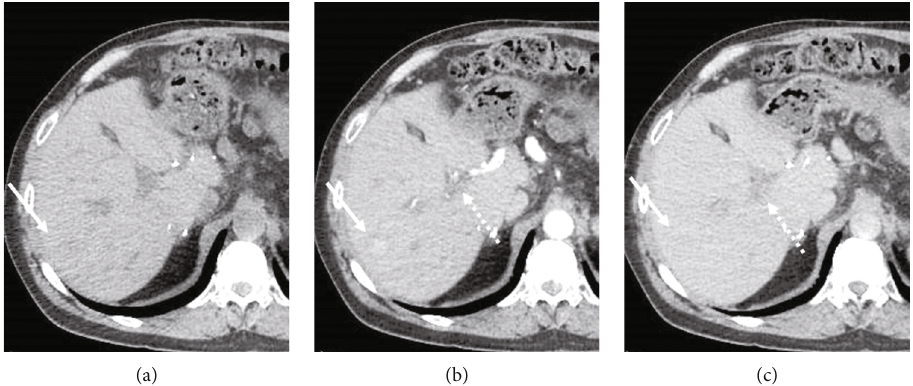
Figure 3: Retrospective review of a contrast-enhanced CT of the liver performed 8 months prior to contrast-enhanced MRI demonstrates portal vein thrombosis (dotted arrow) and a 2.3-cm lesion in segment 7 (arrow) that is faintly hypodense on precontrast (a), enhances centrally with a hypoenhancing rim on arterial phase (b), and subtly hypodense with a subtle rim of hyperenhancement on 3min delay phase (c). In a patient with chronic liver disease, this appearance would be suspicious for HCC.